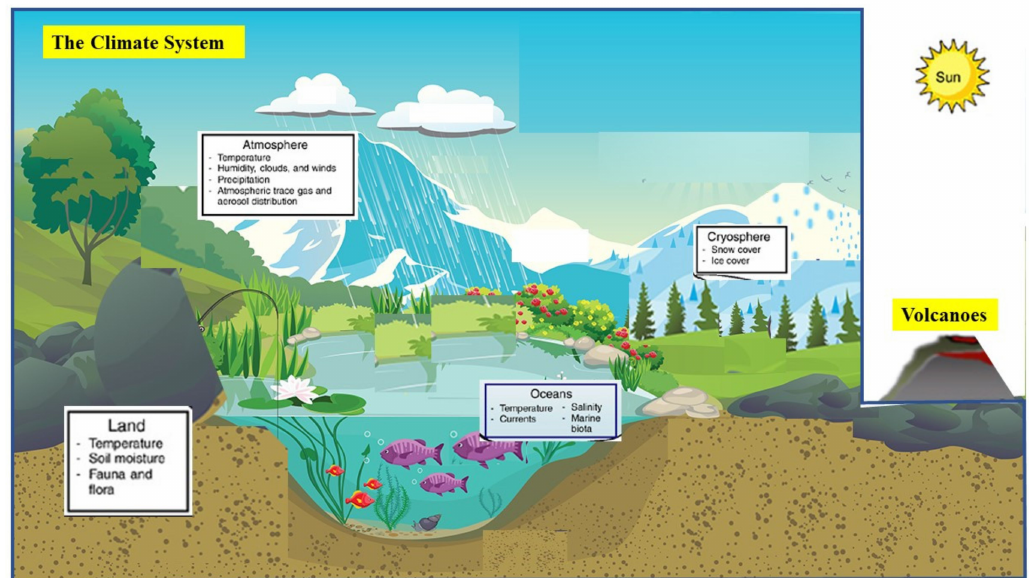
Figure 2. The climate system, consisting of the atmosphere, oceans, land, and cryosphere. Important state variables for each sphere of the climate system are listed in the boxes. For the purposes of this report, the Sun, volcanic emissions, and human-caused emissions of greenhouse gases and changes to the land surface are considered external to the climate system (adapted from [8] by Olusola Festus, University of Missouri Kansas